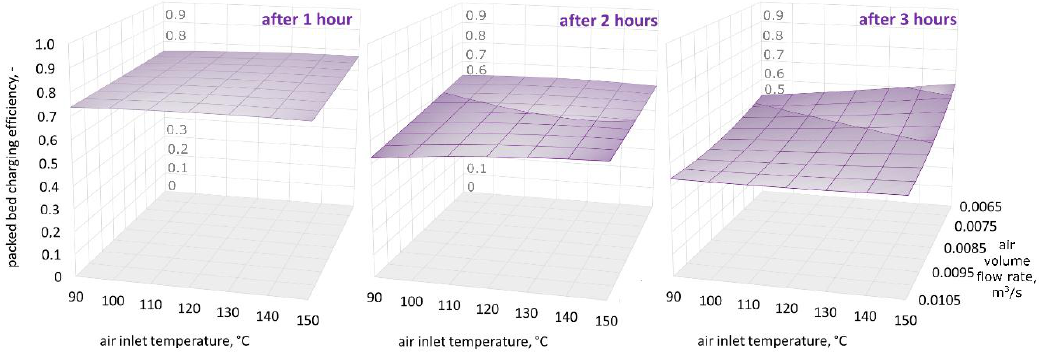
Figure 11. Relationship between the air inlet temperature, the air volume flow rate, and the theoretical efficiency of the packed bed charging process, for a granite sphere diameter equal to 90 mm, after one, two, and three hours of the charging